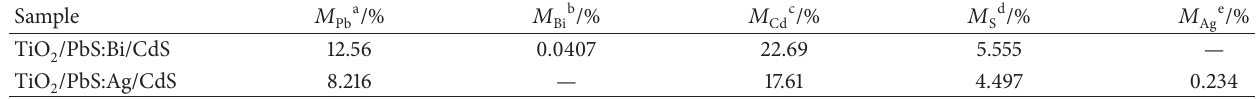
Table 1: Content of atoms in TiO /Bi-doped-PbS and TiO /Ag-doped-PbS solid film. 2 2 Sample 𝑀 Pba /% 𝑀 Bib /% 𝑀 Cdc /% 𝑀 Sd /% 𝑀 Age /% TiO /PbS:Bi/CdS 12.56 0.0407 22.69 5.555 — 2 /PbS:Ag/CdS 8.216 — 17.61 4.497 TiO 2